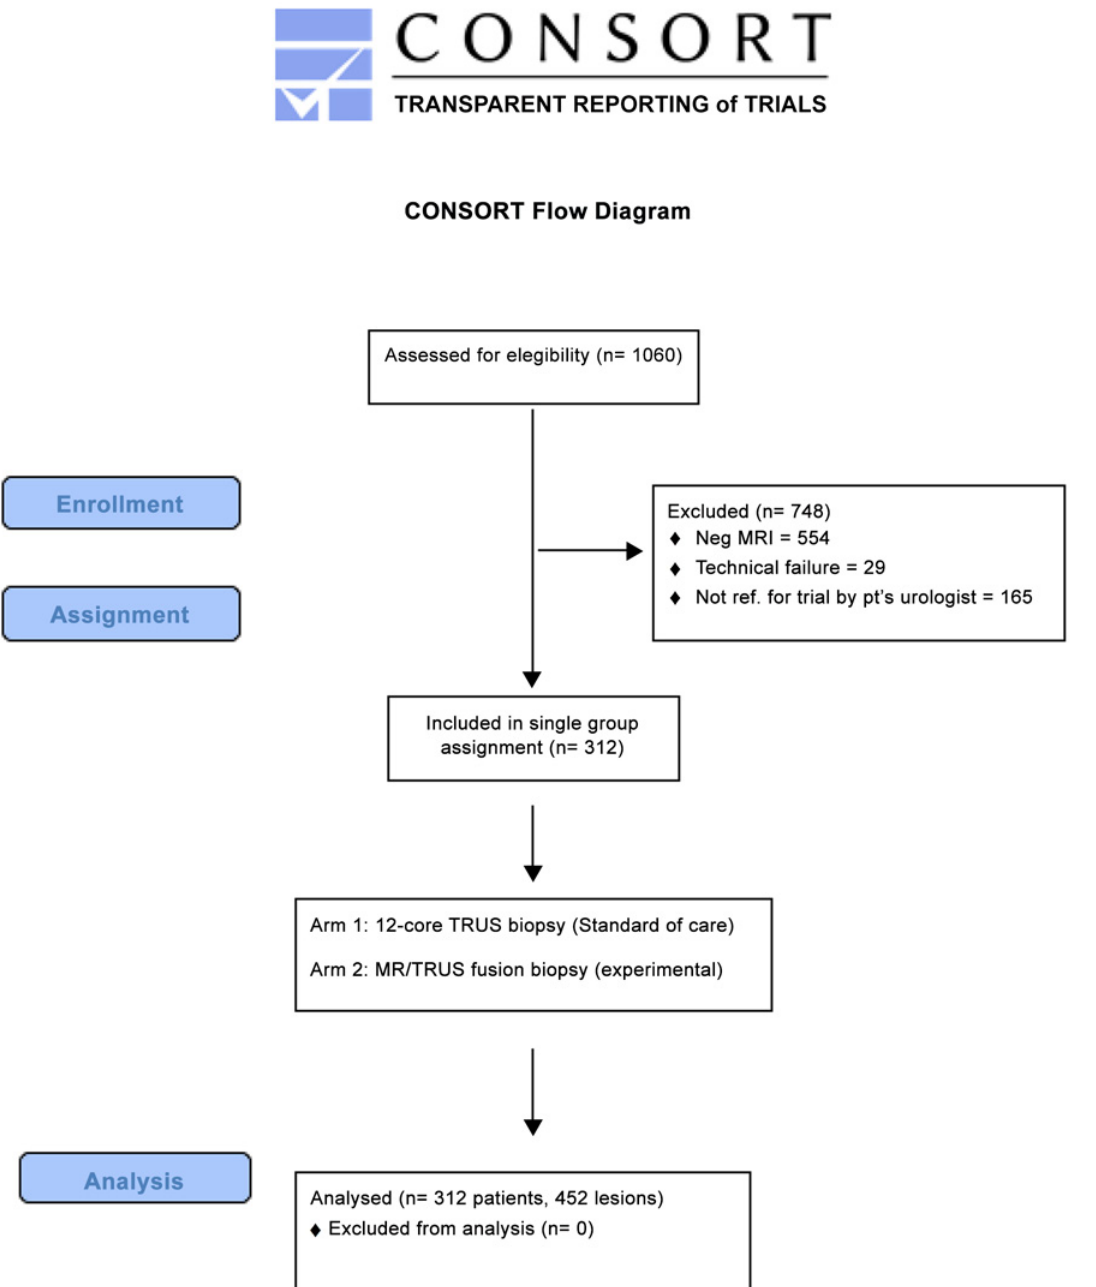
Fig 1. Consort Flow Diagram of trial from enrollment through